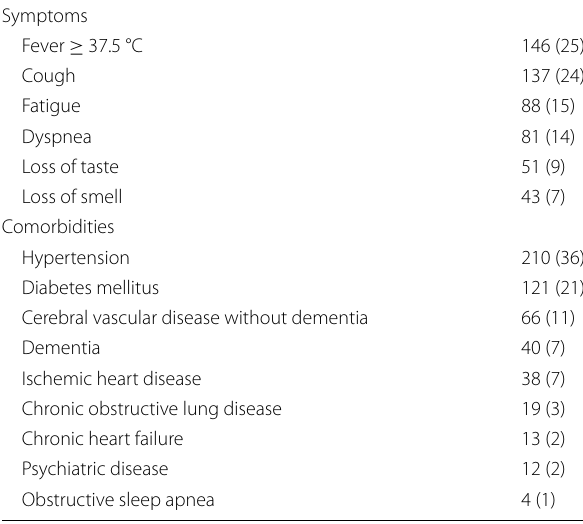
Data are expressed as the number of patients